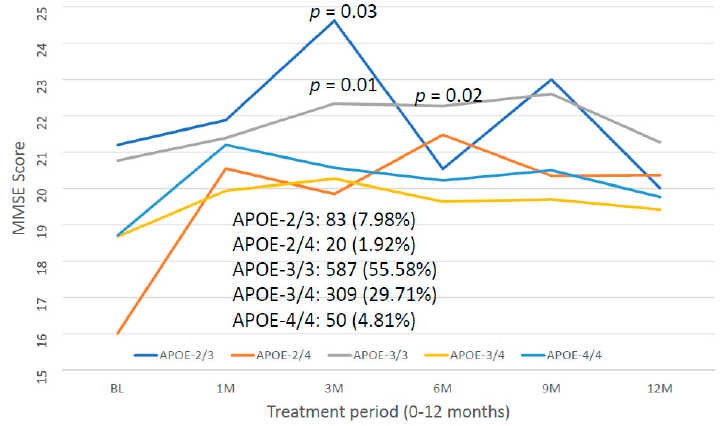
Figure 14. APOE -related therapeutic response to a multifactorial treatment in Alzheimer’s disease.